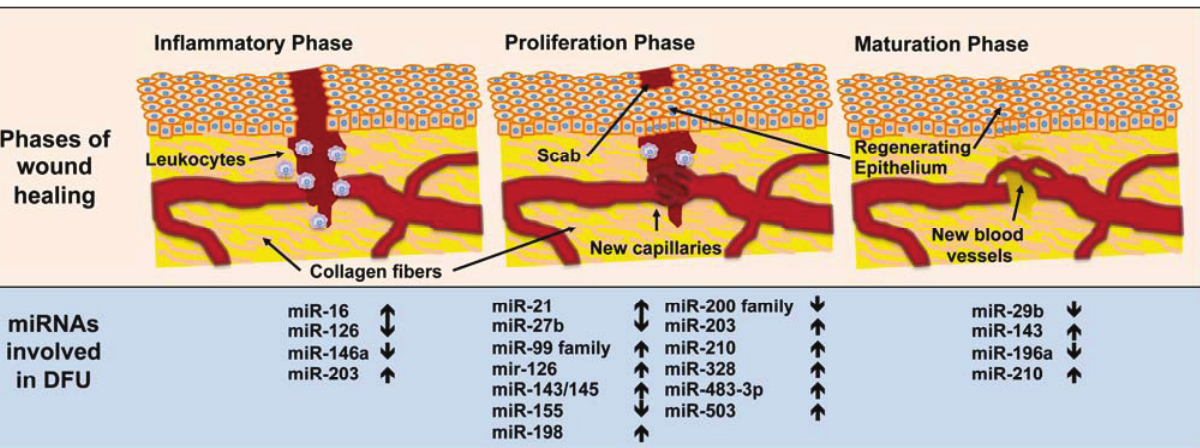
Figure 1. Schematic representation of the different wound healing phases and a summary of the most relevant miRNAs thus far identified, that are involved in wound healing impairment in diabetes. Arrows indicate wound up- or